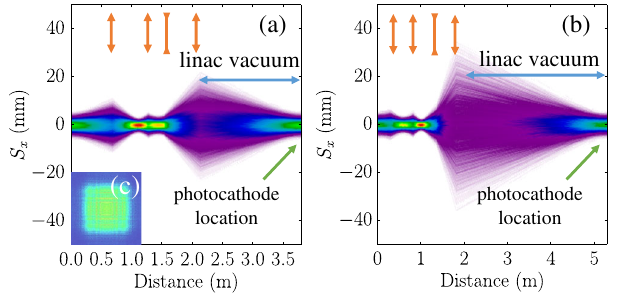
FIG. 2. False color ray-tracing distribution of a four-lens optical line capable of imaging the homogenized beam on the photo- cathode surface. The configuration in (a) and (b) corresponds respectively to the AWA witness-beam (AWA-WB) and drive- beam (AWA-DB) electron-source setups. The lens types and locations are shown as red arrows. The inset (c) gives the intensity distribution simulated using the vectorial-diffraction program SRW for a 5 × 5 rectangular